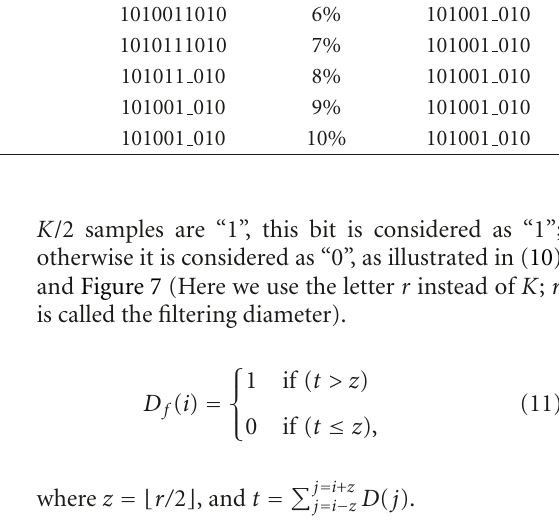
Table 3: Robustness to cropping (Watermark length = 10). Time